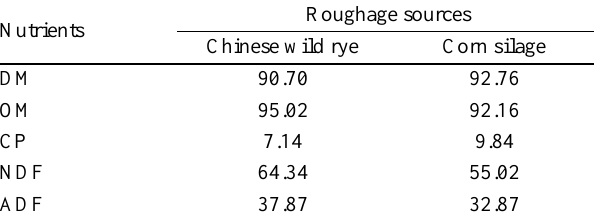
Table 1. Chemical composition of two roughages (DM basis) Nutrients